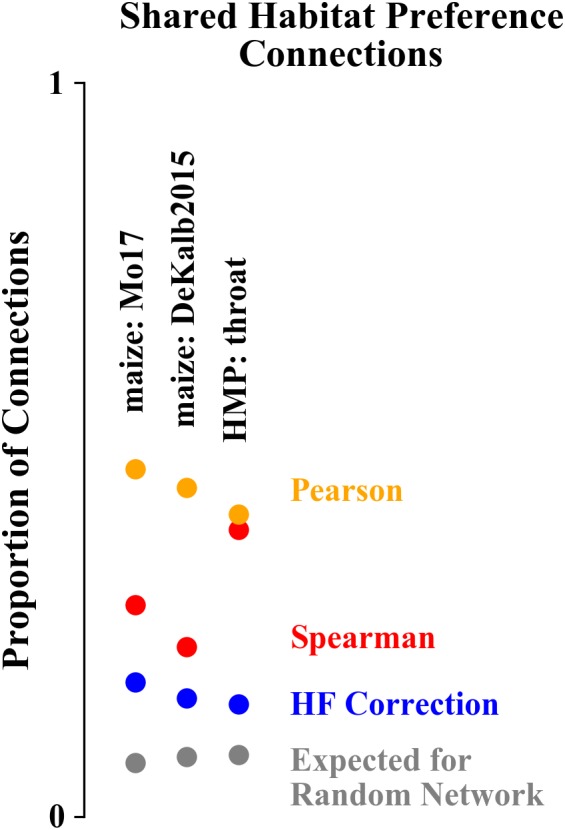
Proportion of network correlations that are between ASVs/OTUs with a shared habitat preference. Networks constructed with Pearson correlations have the highest proportion of shared habitat preference correlations while HF corrected networks have the lowest.